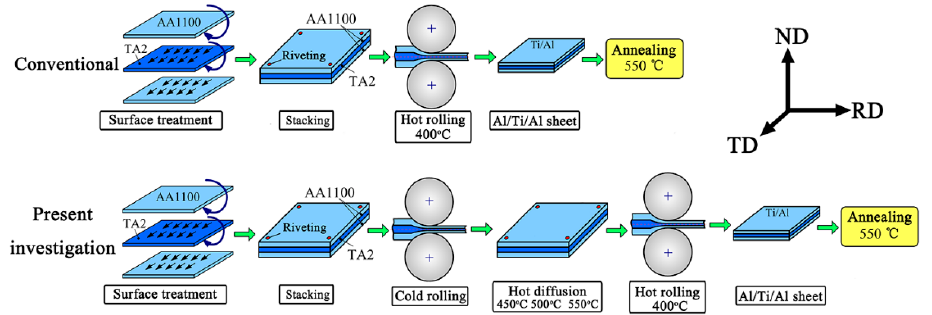
Figure 1. Schematic illustration showing the method for fabrication of Al / Ti laminated metal composites